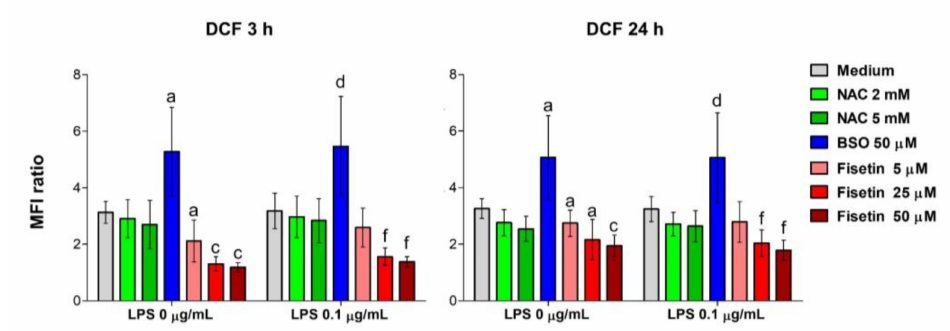
Figure 2. Generation of reactive oxygen species in human pulp cells. Cell cultures were treated under various experimental conditions in complete growth medium (M1) for 3 h or 24 h. The bar graphs represent the mean fluorescence intensity (MFI) ratio related to the formation of reactive oxygen species detected after staining with DCF. Values found with unstained sample are set to 1 (not shown). Bars show mean values ± standard deviations summarized from individual values in independent experiments (n = 6). Significant differences between 0 µ M (=M1) and treated samples: a ( p < 0.01) and c ( p < 0.0001) between 0 µ M and treated samples without LPS (0 µ g/mL); d ( p < 0.01), and f ( p < 0.0001) between LPS alone and treated samples in the presence of LPS (0.1 µ g/mL). BSO